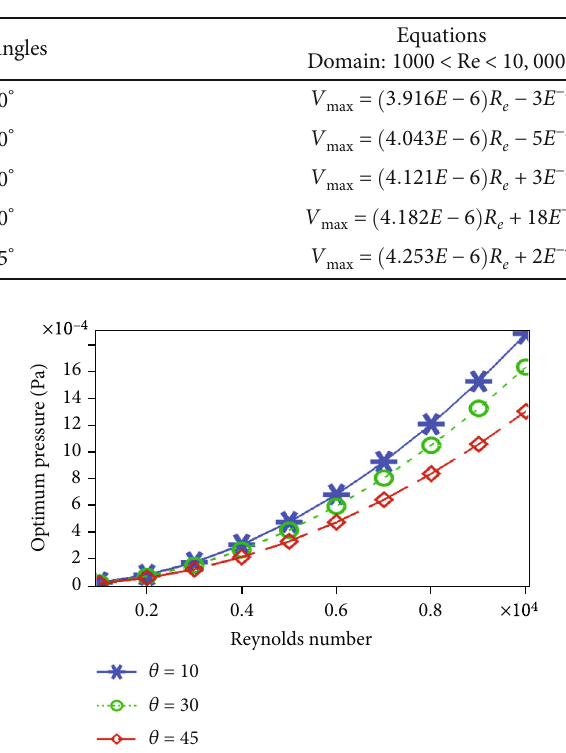
Figure 7: The optimum pressure is the function of Reynolds number.